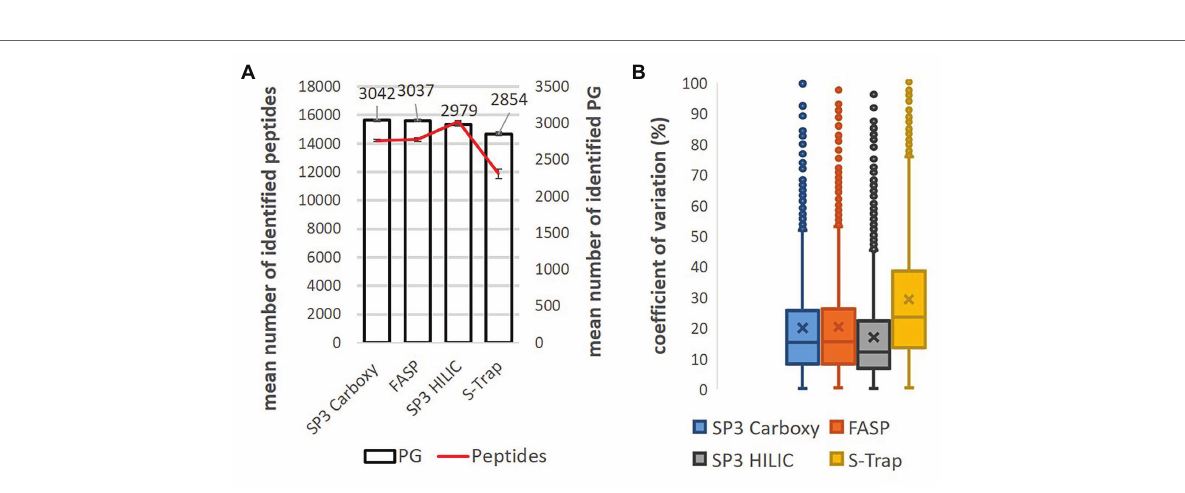
FIGURE 1 | Peptide recoveries based on peptide concentration obtained by tryptophan assay. The recoveries are not corrected to trypsin addition.